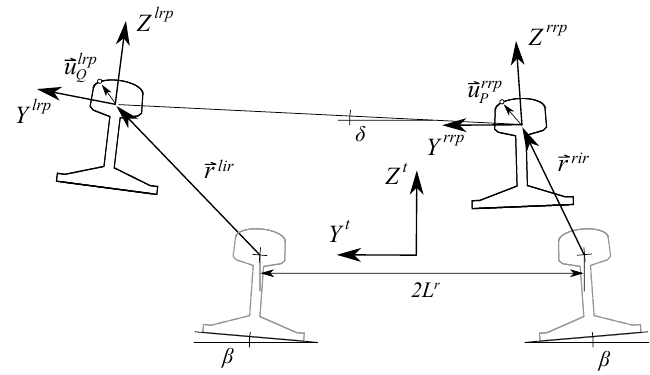
Figure 3. Kinematics of the irregular track